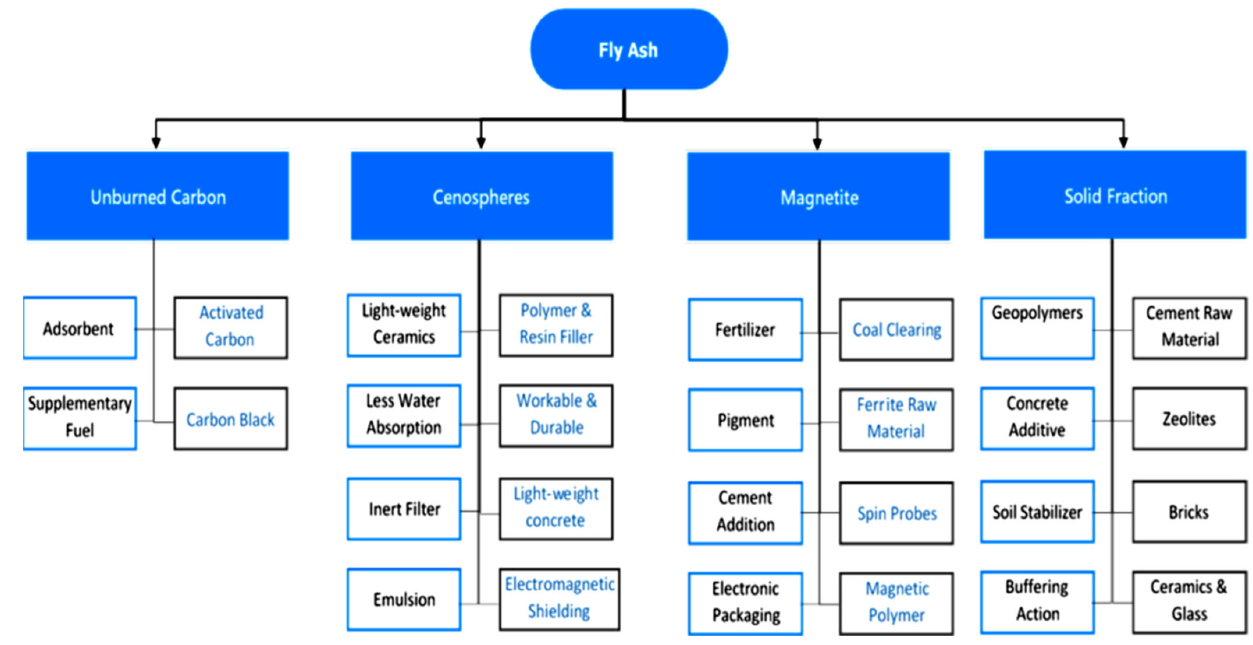
Figure 5. FA’s main components and applications. Adapted from [52].